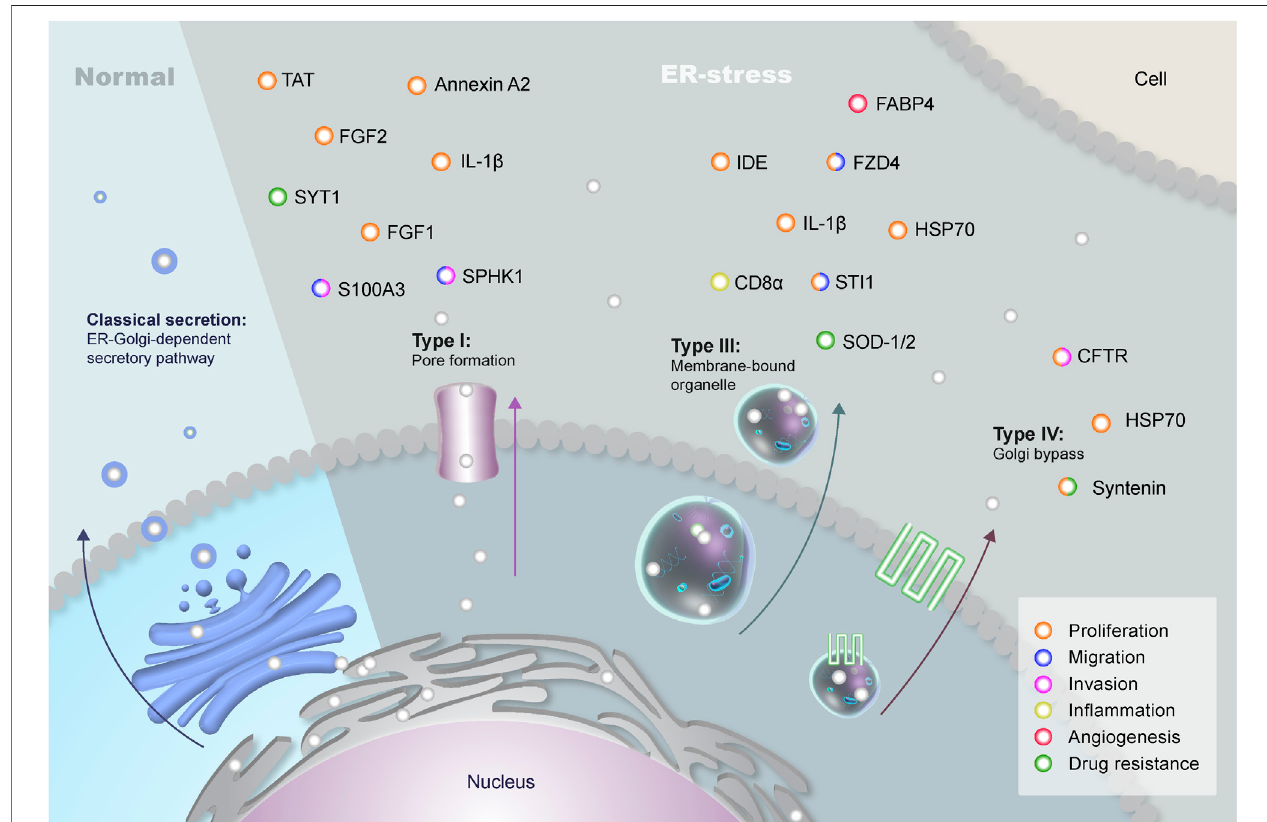
FIGURE 1 | Types of Unconventional Protein Secretion in Eukaryotes. The classical secretion of proteins containing signal peptides involves the endoplasmic reticulum(ER)and theGolgi complexduringnormalconditions.TheseproteinsaretransportedthroughvesiclesthatbudofftheGolgicomplexand fusewiththeplasma membrane. However, leaderless proteins can be secreted through an unconventional pathway (UPS) that bypasses the Golgi during stress conditions. There are four different USPs in eukaryotes: Type I, in which proteins are secreted through a pore in the plasma membrane; Type II, with the transport of proteins through the superfamily of ATP-binding cassette (ABC) transporters (not shown in the fi gure); Type III, which uses autophagosomes/endosomes to transport proteins to the extracellular;andtypeIV,inwhichproteinscontainingasignalpeptidearesecretedbypassingtheGolgi.BraintumorscanmakeuseofthreedifferenttypesofUPS:typeI (membranepores),typeIII(differential vesicles),andtypeIV(Golgibypass).Theplethoraofproteinssecreted throughUPScaninteractwithneighboringcells,promoting distinct pathways of key importance in GBM biology, such as proliferation (orange), migration (blue), invasion (pink), in fl ammation (yellow), angiogenesis (red) and drug resistance